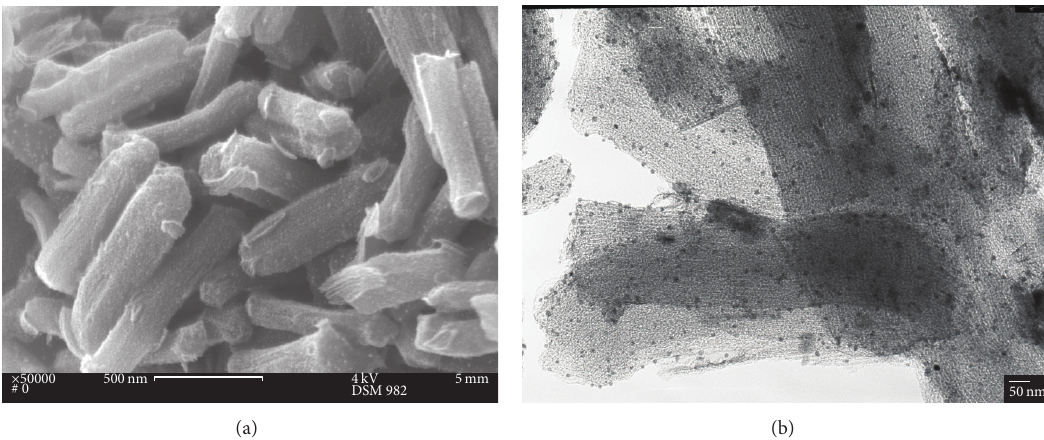
F 3: (a) SEM and (b) TEM images of magnetic mesoporous FePt/C composites (scale bar in (a): 500nm; scale bar in (b): 50nm).